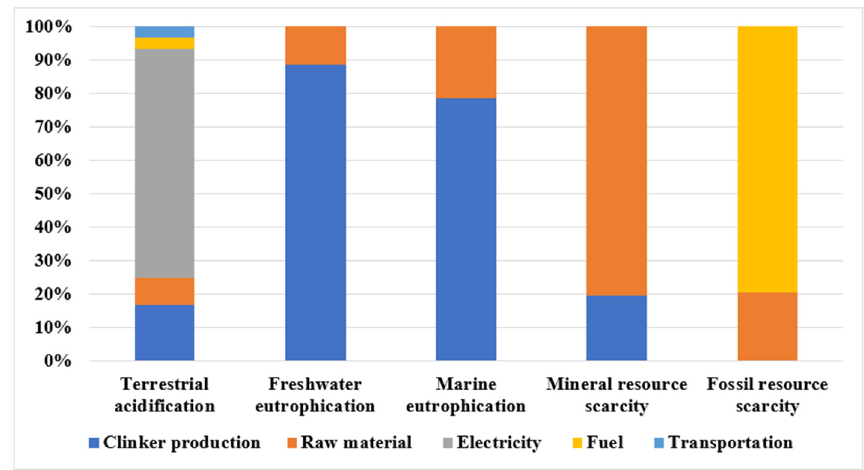
Figure 3. Contribution of each production stage to resource depletion.